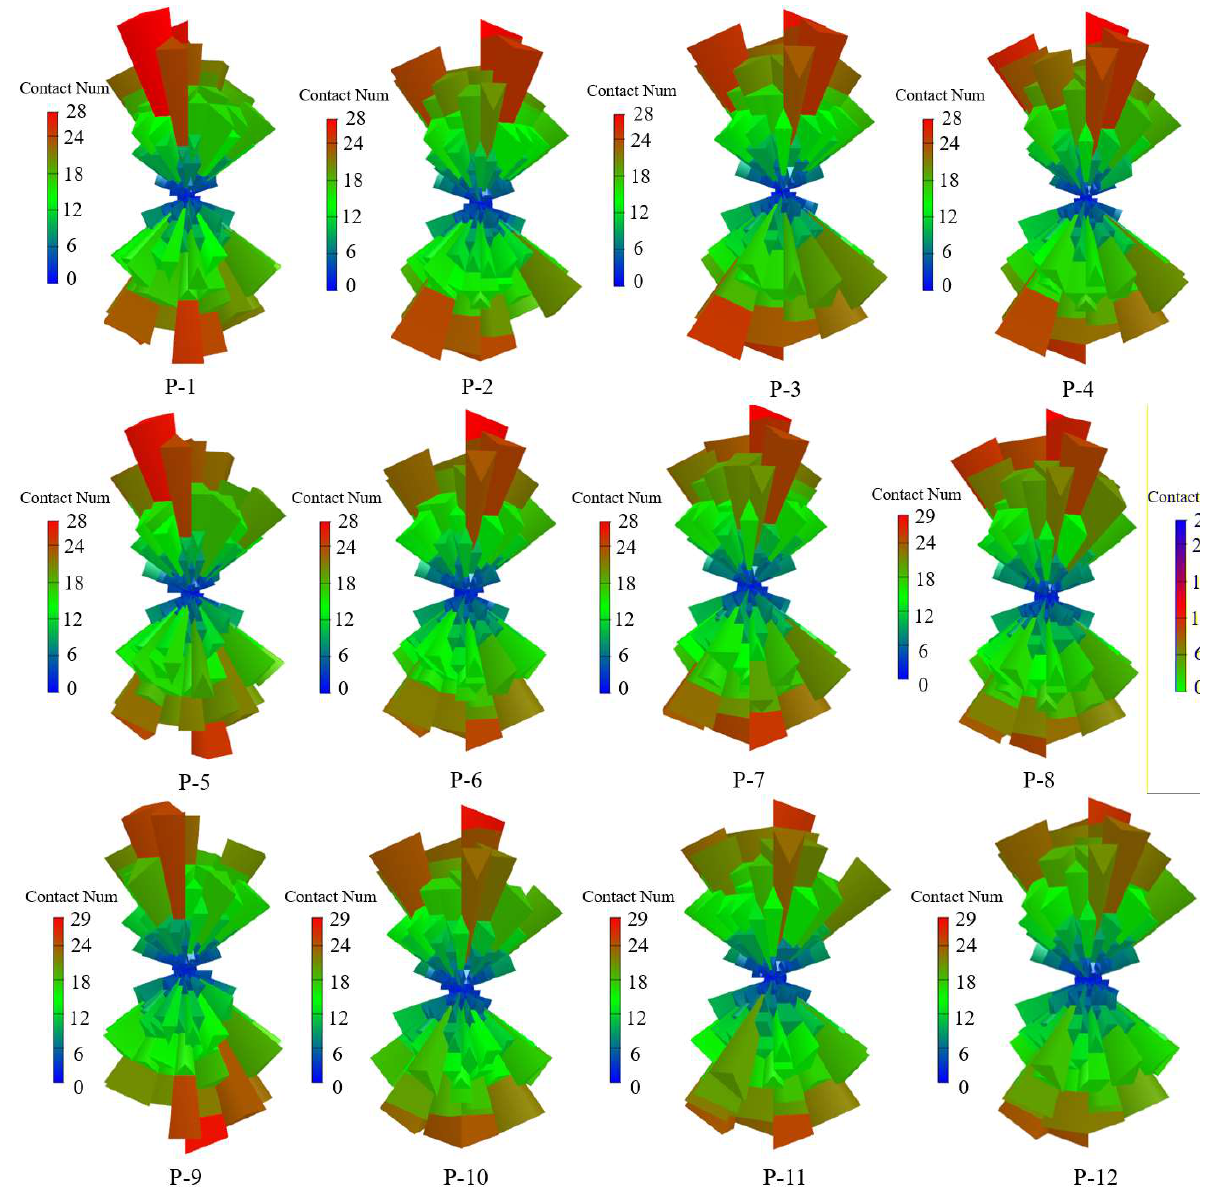
Figure 13. Number of contacts in different orientations.